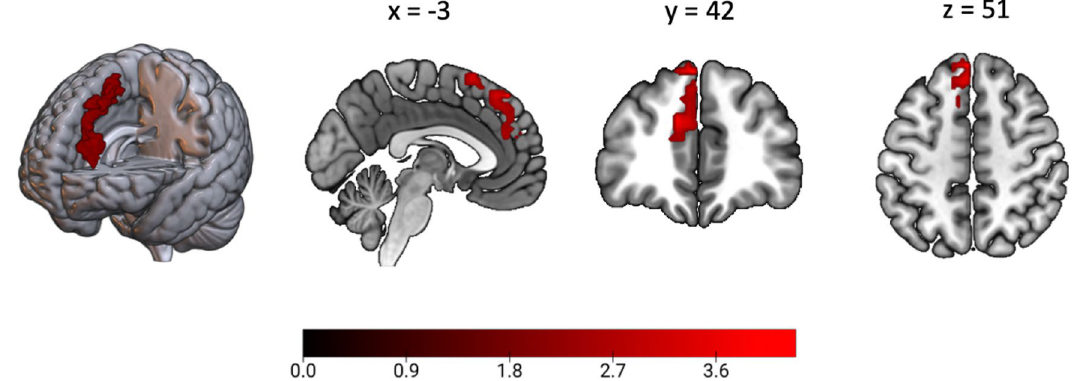
Figure 1. Significant positive correlation with EPDS score at T4 in the left superior medial frontal gyrus. For visualization purposes the region showing a significant whole-brain corrected voxel-wise association with EPDS at T4 is displayed at p < .01 uncorrected at